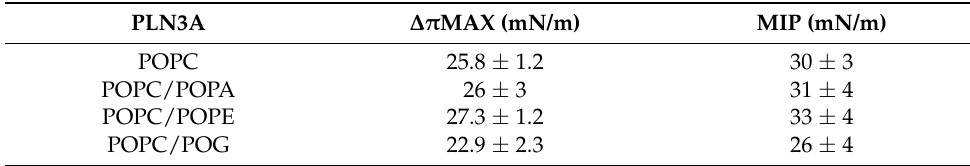
Table 3. Maximum change in monolayer pressure on triolein drop, ∆ π MAX , and MIP data derived from Figure 5b for the full-length perilipin 3 construct. Uncertainty values represent 95% confi- dence